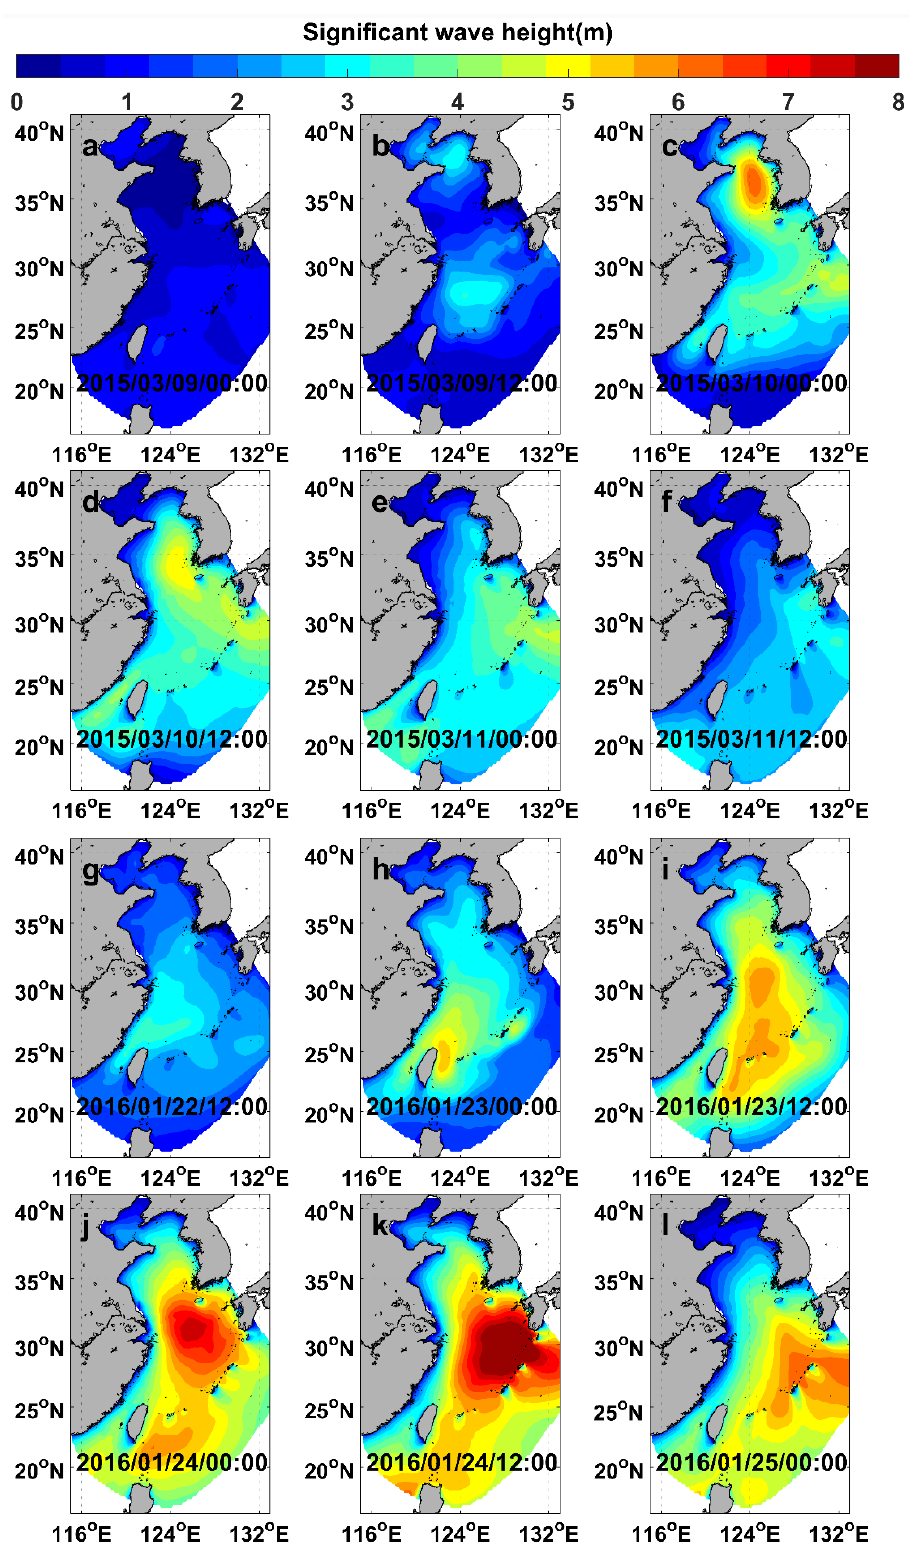
Figure 5. ( a – f ) The distribution of simulated SWHs in the ECS from 9 March 2015, to 11 March 2015.